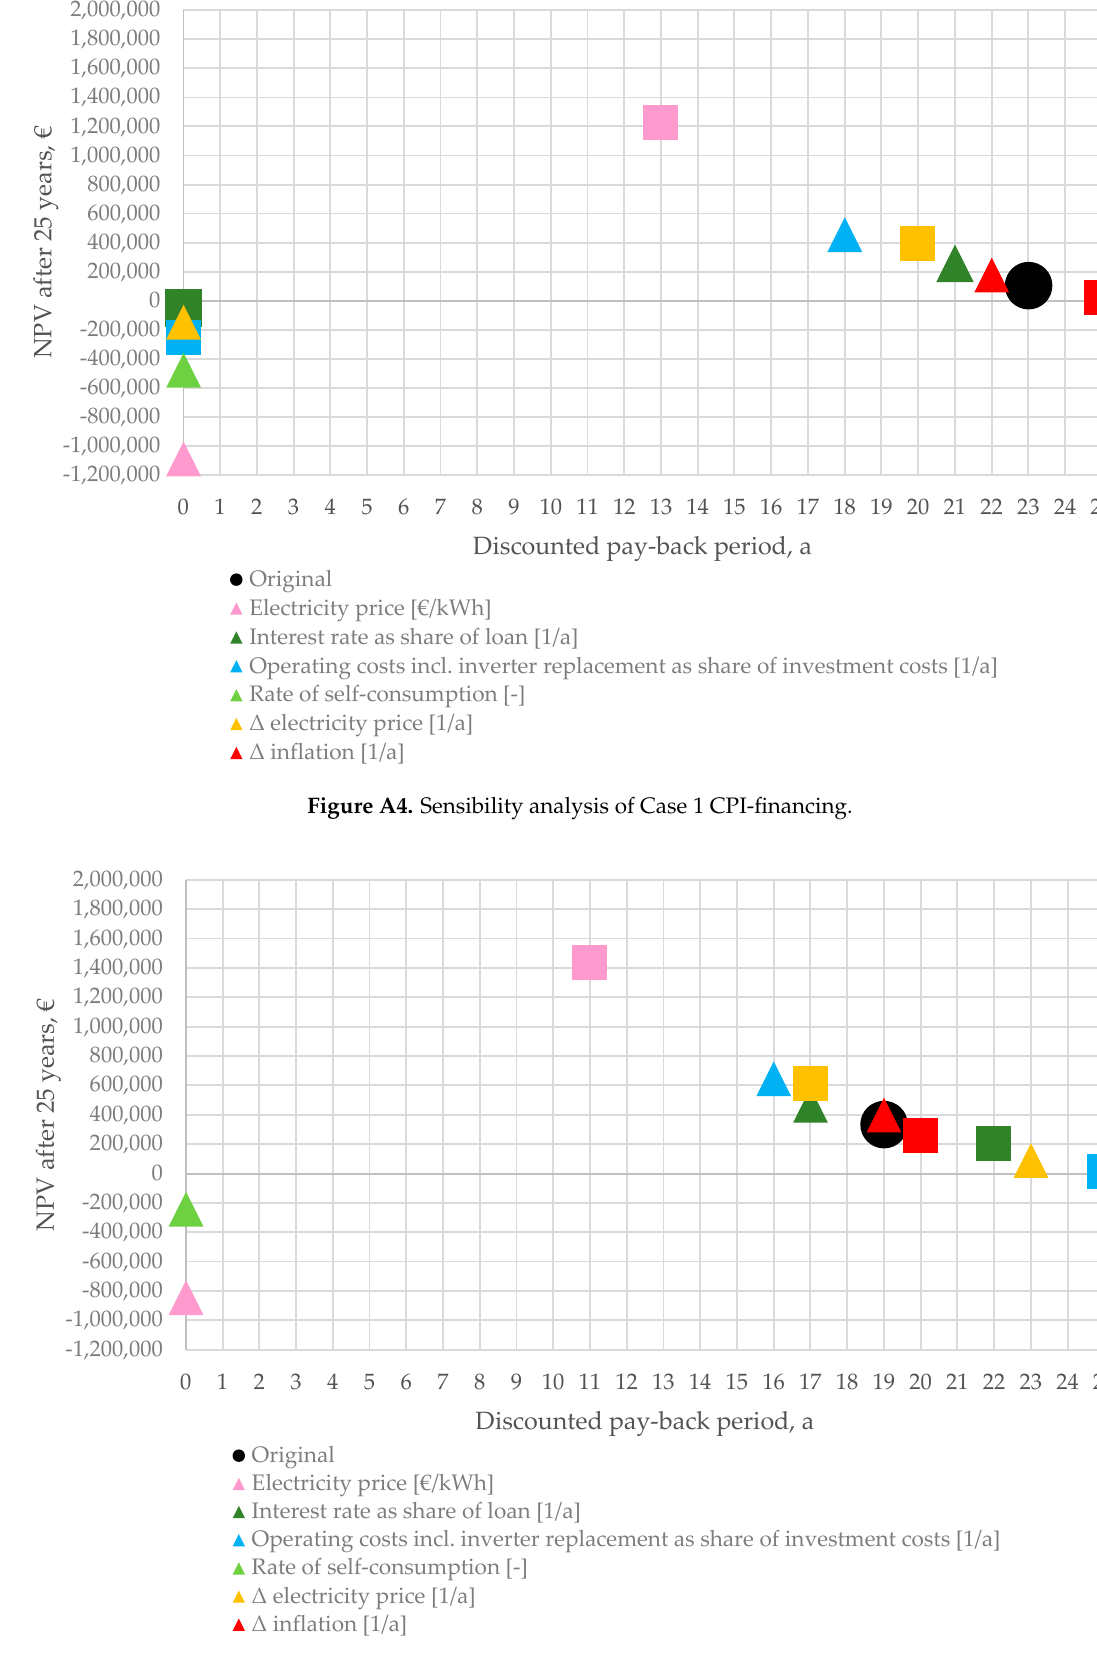
Figure A5. Sensibility analysis of Case 2 CPI-Financing.